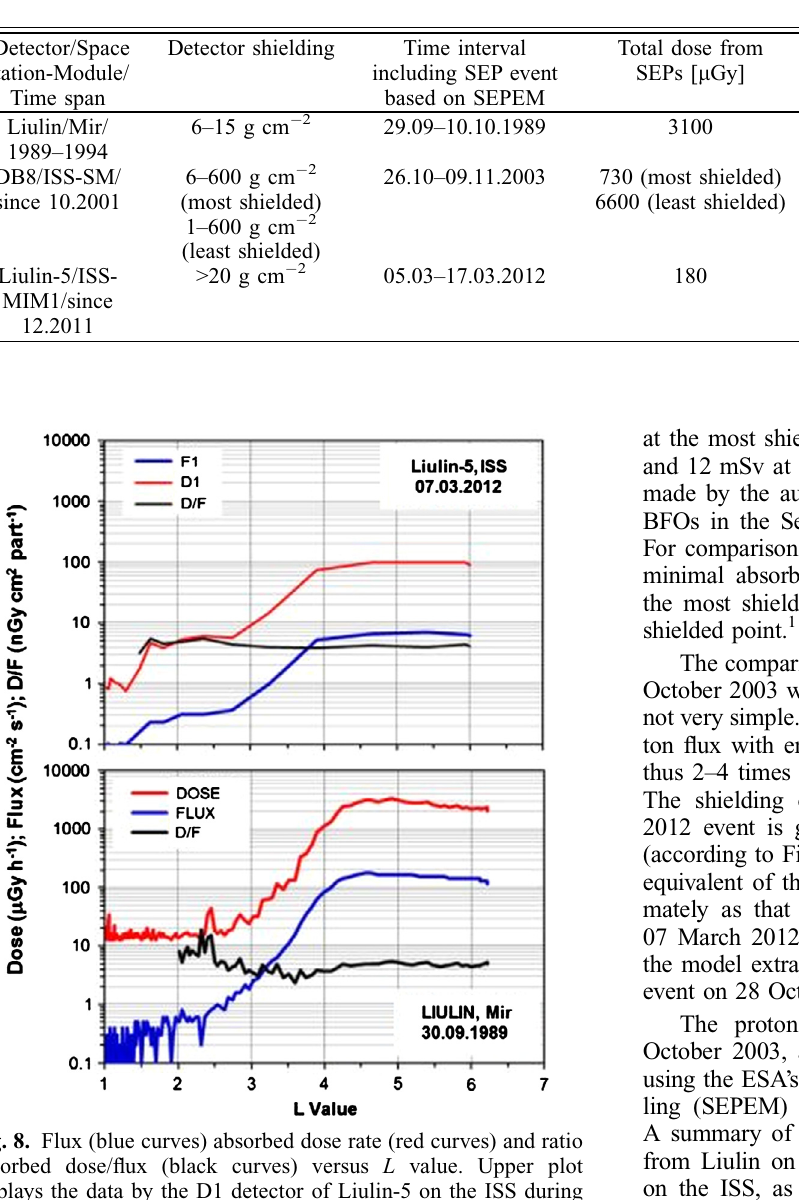
Table 3. Summary of results obtained during some of the largest SEP events from different experiments for radiation measurements with silicon detectors onboard Mir and ISS during 22nd, 23rd and 24th solar cycles. The analytical fits of the total event spectra and peak event spectra for the energy channels of the SEPEM proton reference dataset and reference event list (http://dev.sepem.oma.be/) for these SEP events are shown in Columns 5 and 6.